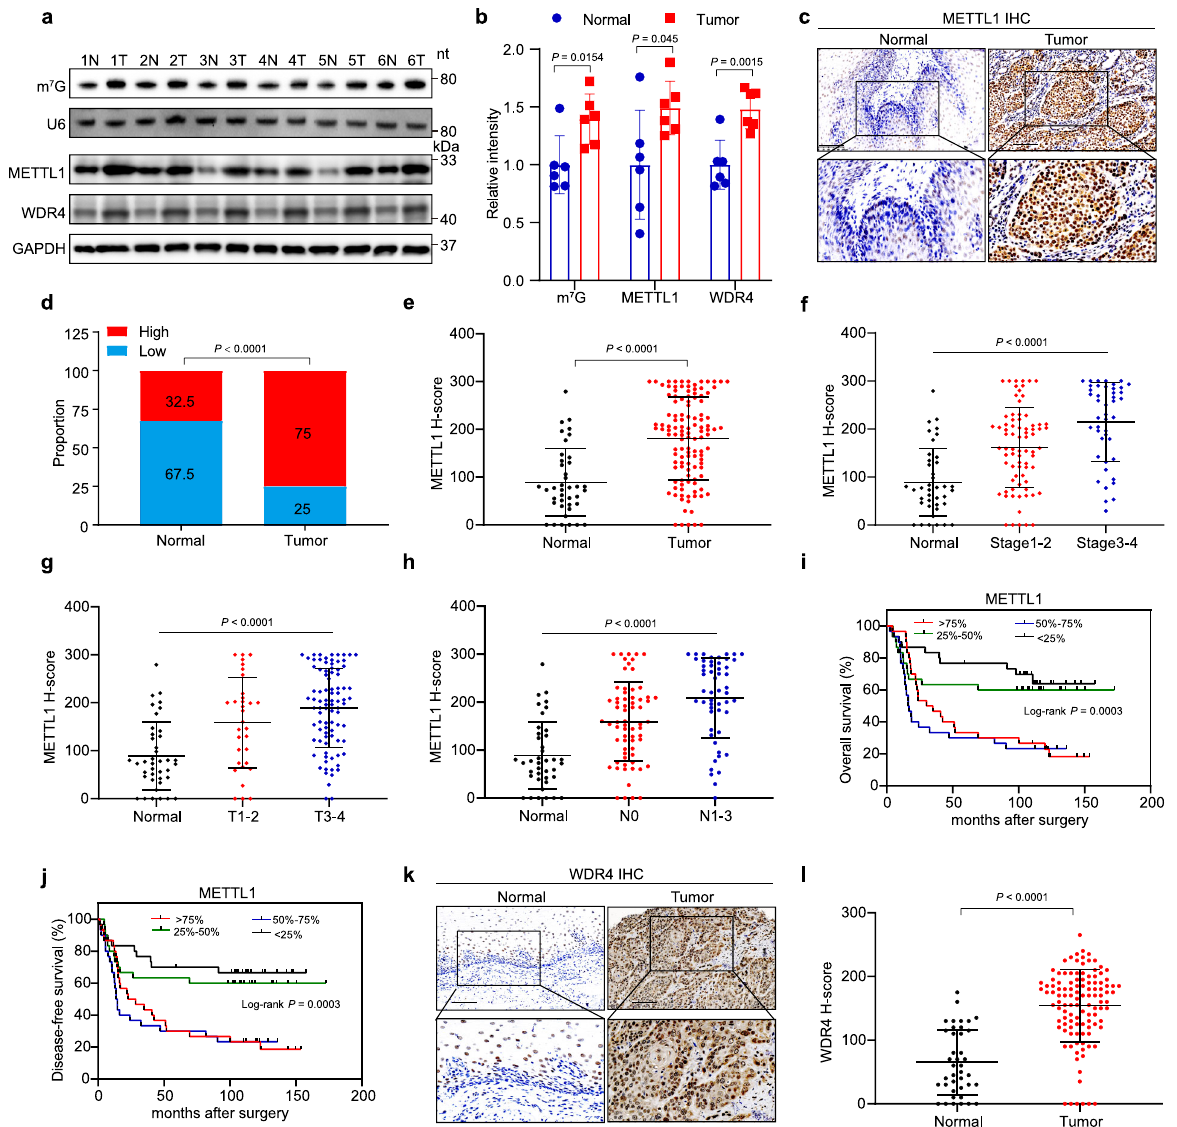
Fig. 1 METTL1 is elevated in ESCCs and is a negative prognostic factor for ESCC patients. a , b Blotting assays ( a ) and the quantitative analysis ( b ) of METTL1, WDR4, and m 7 G levels in ESCC tumors and adjacent control normal tissues. N, Normal. T, Tumor. c Representative images of METTL1 IHC staining in esophageal tumor tissues and adjacent normal tissues. Scale bar, 100 μ m. d Proportion of METTL1 expression cases in adjacent normal tissues and esophageal tumor tissues. e Quanti fi cation of METTL1 H-scores in esophageal tumor tissues and adjacent normal tissues. f Quanti fi cation of METTL1 H-scores in adjacent normal tissues and different stages of esophageal tumor tissues. g Quanti fi cation of METTL1 H-scores in adjacent normal tissues and different grades of esophageal tumor tissues. h Quanti fi cation of METTL1 H-scores in adjacent normal tissues and esophageal tumor tissues with different stages of lymph node metastasis. i , j Kaplan – Meier analysis of the overall survival ( i ) and disease-free survival ( j ) of ESCC patients based on H-scores of METTL1. k Representative images of WDR4 IHC staining in esophageal tumor tissues and adjacent normal tissues. l Quanti fi cation of WDR4 H-scores in esophageal tumor tissues and adjacent normal tissues. Data are presented as mean ± SD from six independent patient samples for ( b ) and 120 patient samples for ( c , e – h , and l ). P values are indicated by two-tailed unpaired Student ’ s t test for ( b ), Pearson chi-square test for ( d ), Mann – Whitney U test for ( e , l ), Kruskal – Wallis test for ( f – h ), and log-rank test for ( i , j ). Source data are provided as a Source data fi le. The source data of ( i , j ) are protected and are not available due to data privacy